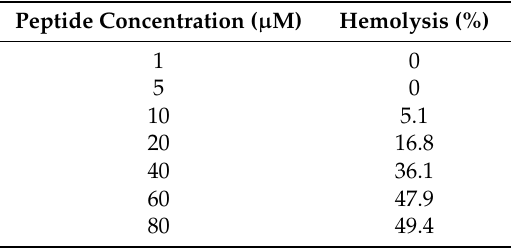
Table 9. Hemolytic effect A3 on human erythrocytes after 60 min of incubation. Results represent